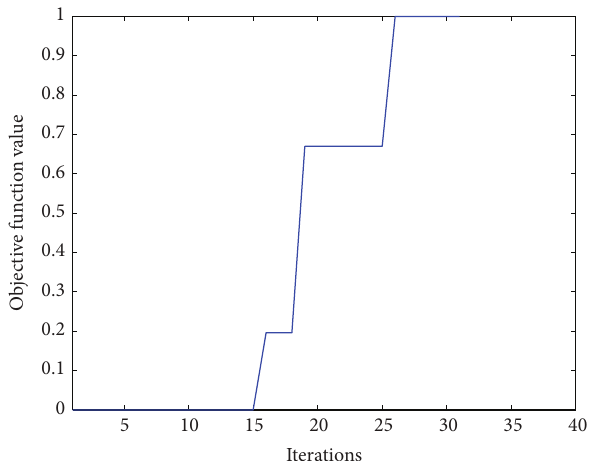
Figure 9: The curve of objective function with iterations.